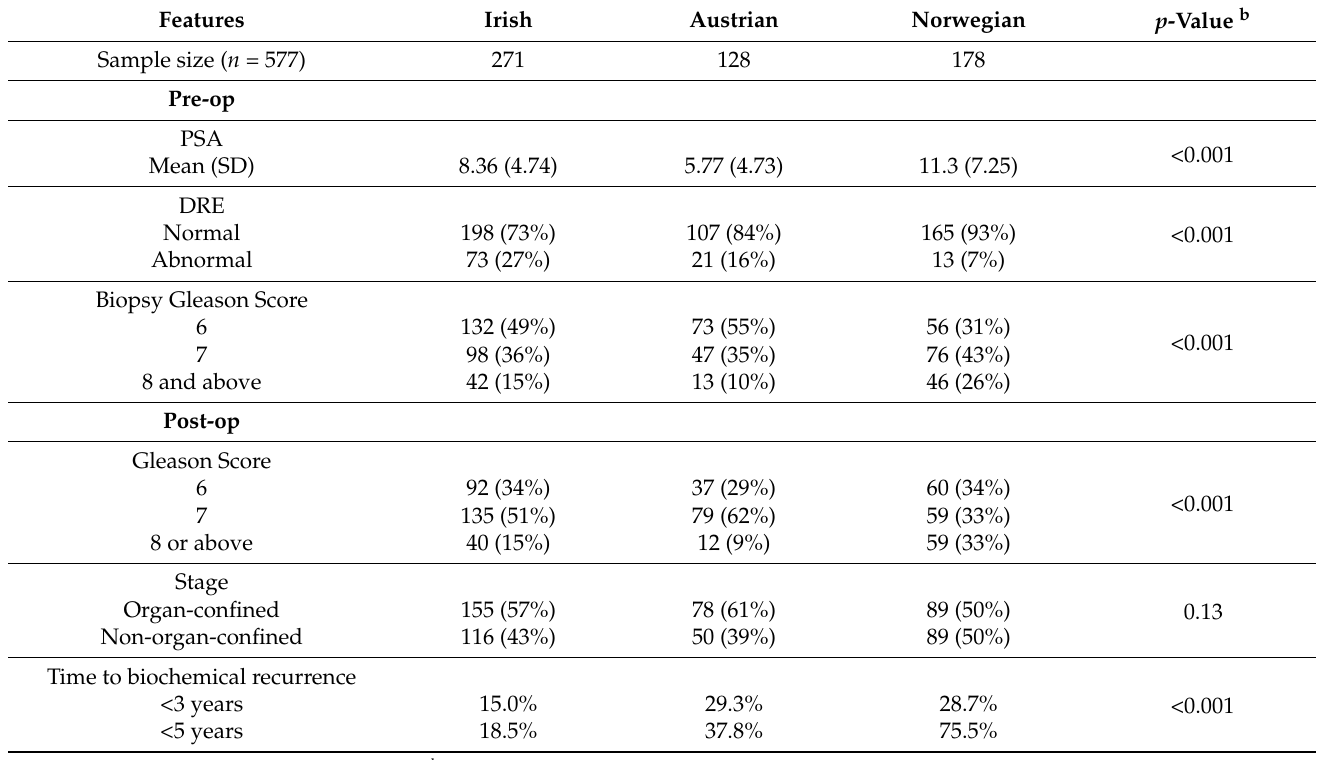
Table 1. Clinical characteristics of the patients by cohorts, and the univariate p -value for each clinical variable a .